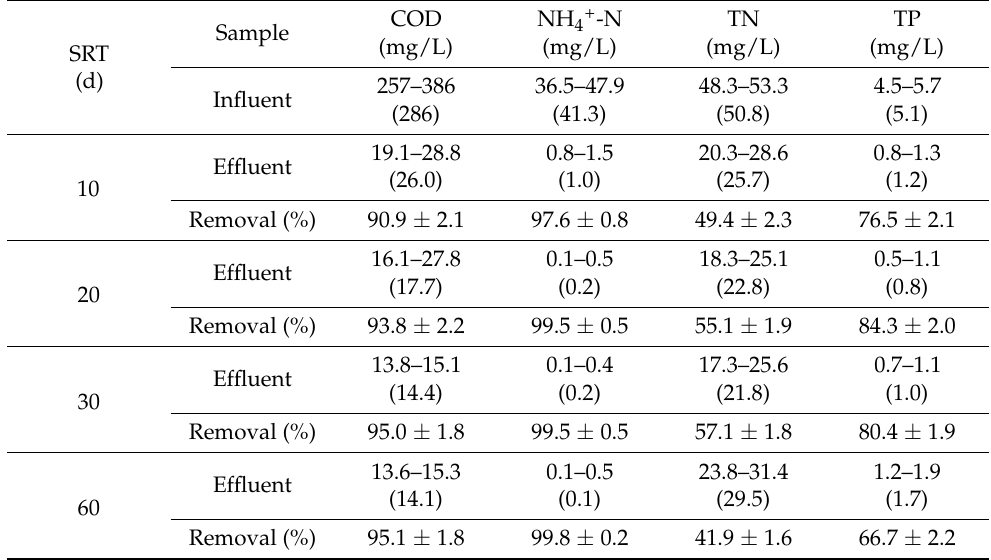
Table 3. Organic and nutrients removals by HMBR under different SRT